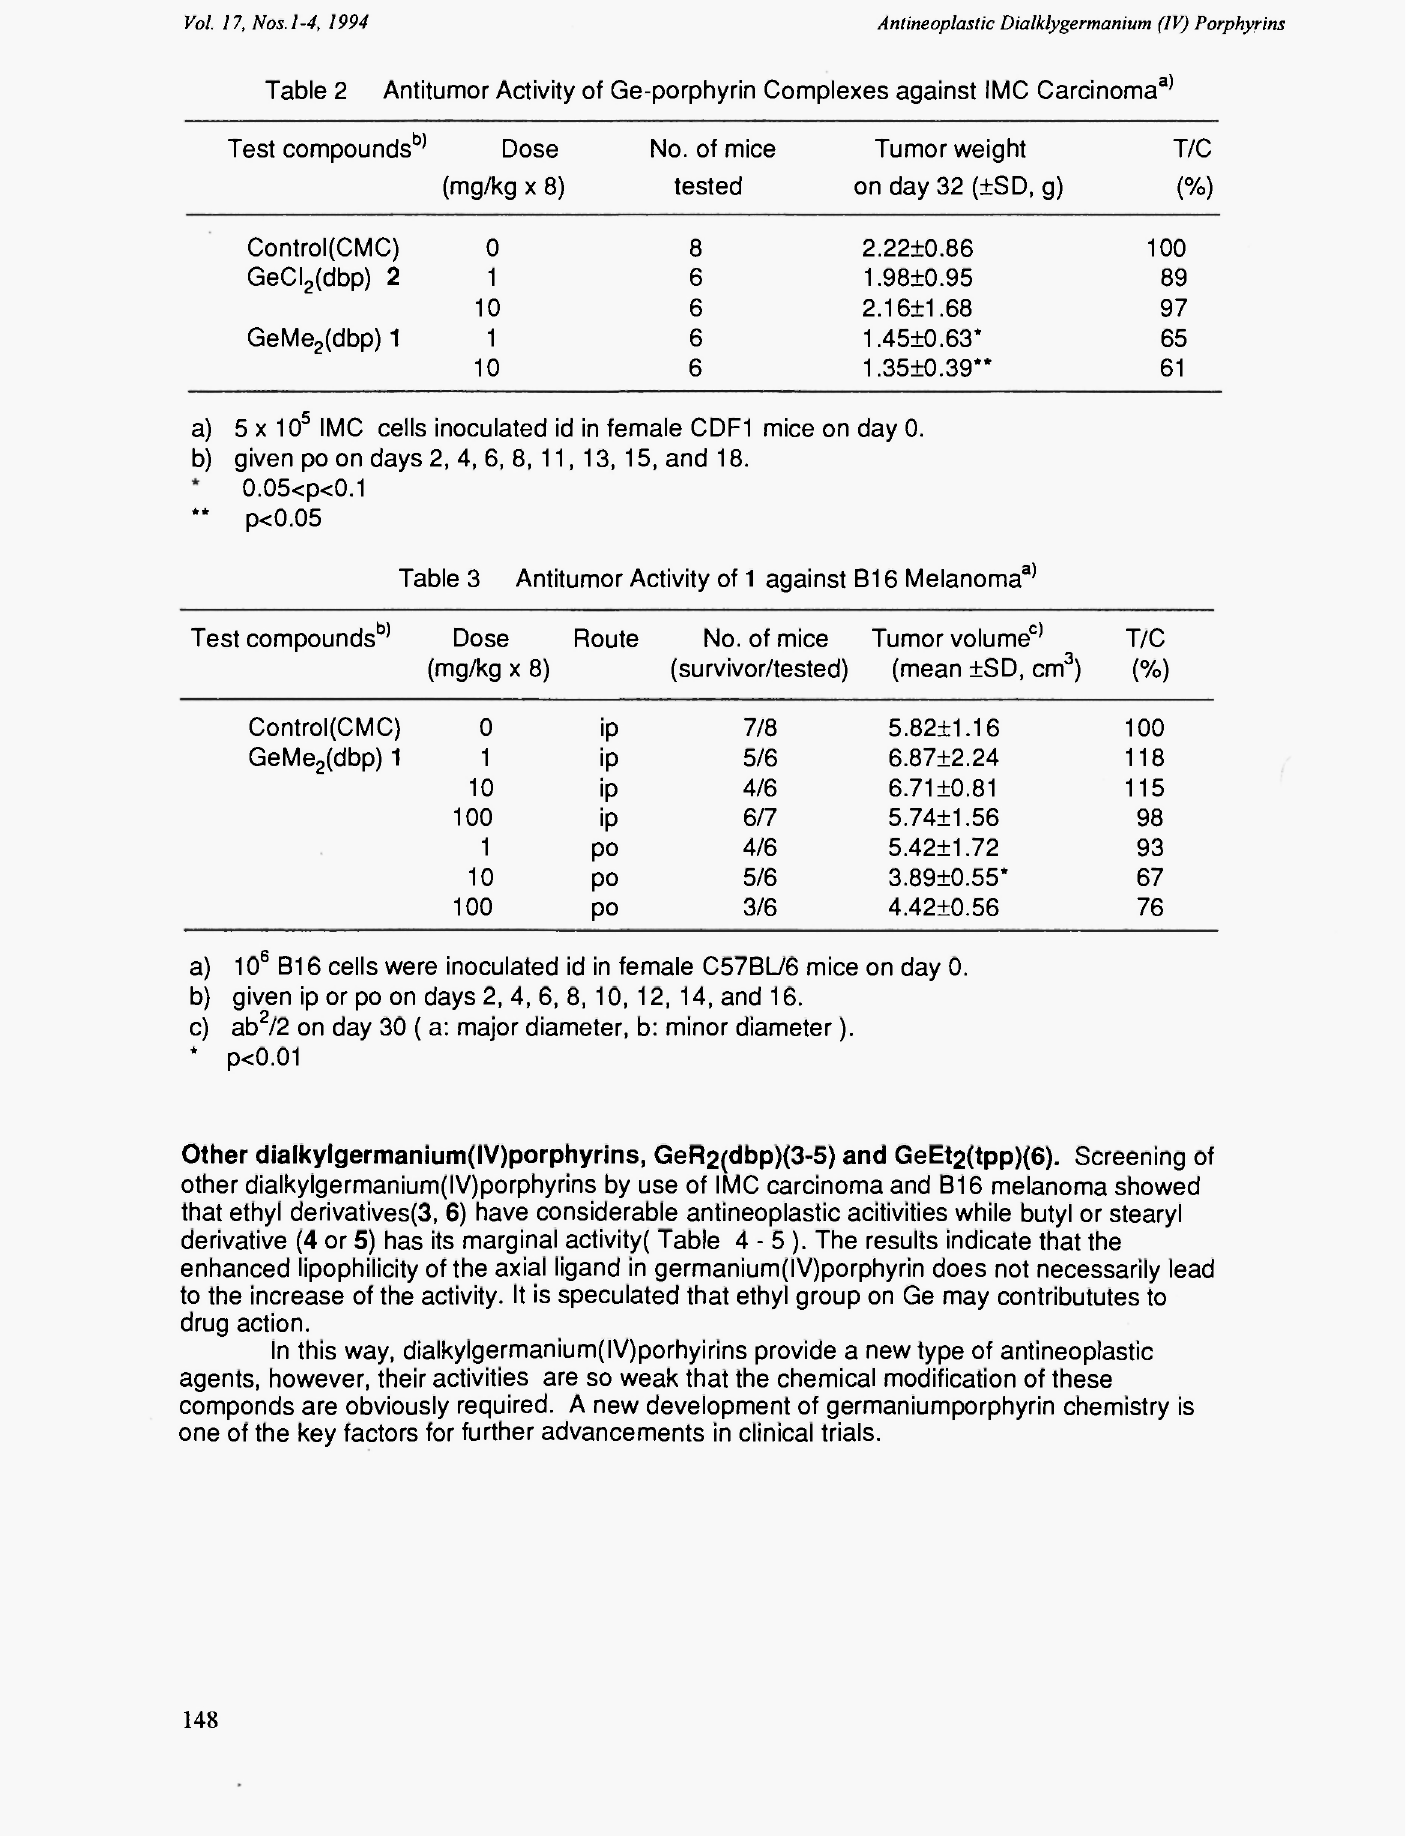
Antitumor Activity of 1 against B16 Melanoma 3 ' Test compounds 6